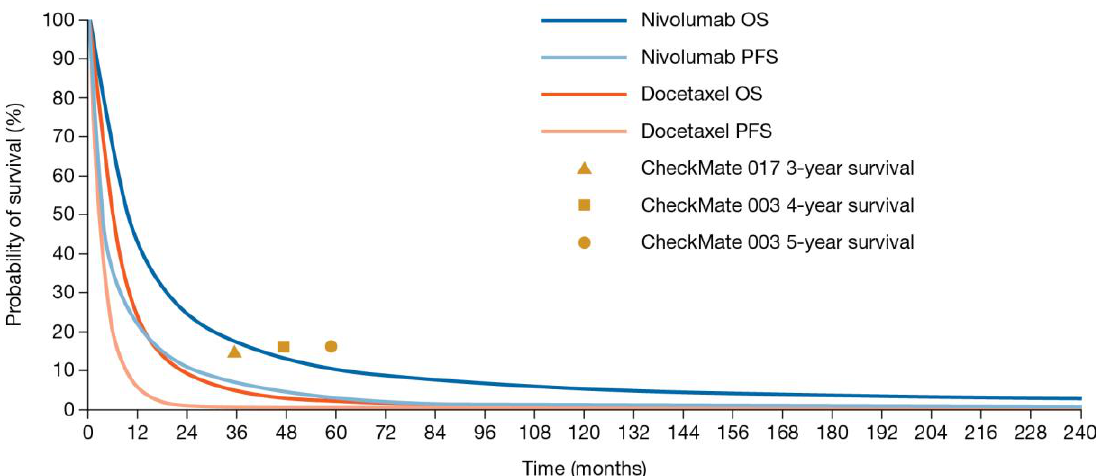
Figure 3: Parametric curves for OS and PFS extrapolated over a lifetime horizon with validation using nivolumab trials with longer follow-up (squamous analysis; CheckMate 017) OS = overall survival; PFS = progression-free survival. Table 1: Mean EQ-5D-3L values from the squamous analysis (CheckMate 017) by health state Country (reference for tariff) Progression-free Progressed disease health state utility health state utility Mean (95% CI) Mean (95% CI) UK (Dolan 1997) 0.750 (0.734, 0.765) 0.592 (0.550, 0.634) Sweden (Burstrom et al. 2014) 0.841 (0.833, 0.849) 0.764 (0.746,